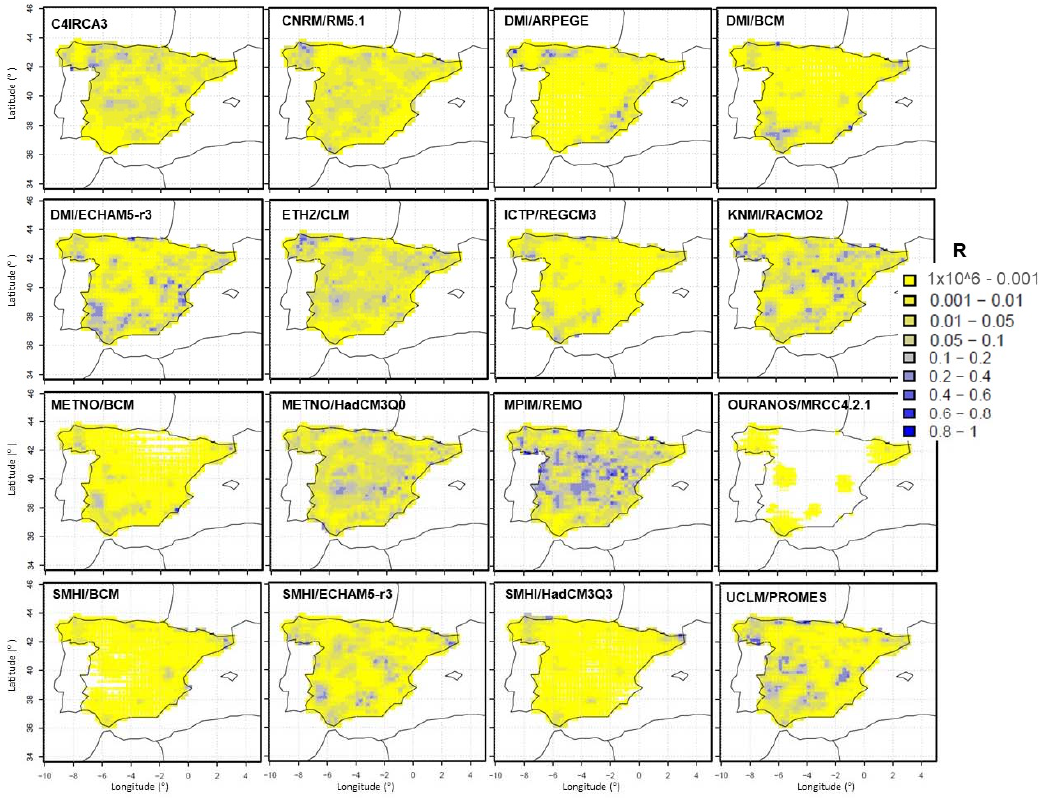
Figure 2. Maps of R values for average temperature, estimated by applying the Smirnov-Kolmogorov test (two-sample Smirnov-Kolmogorov test (TSSK) p value) for each Regional Climate Models (RCM).